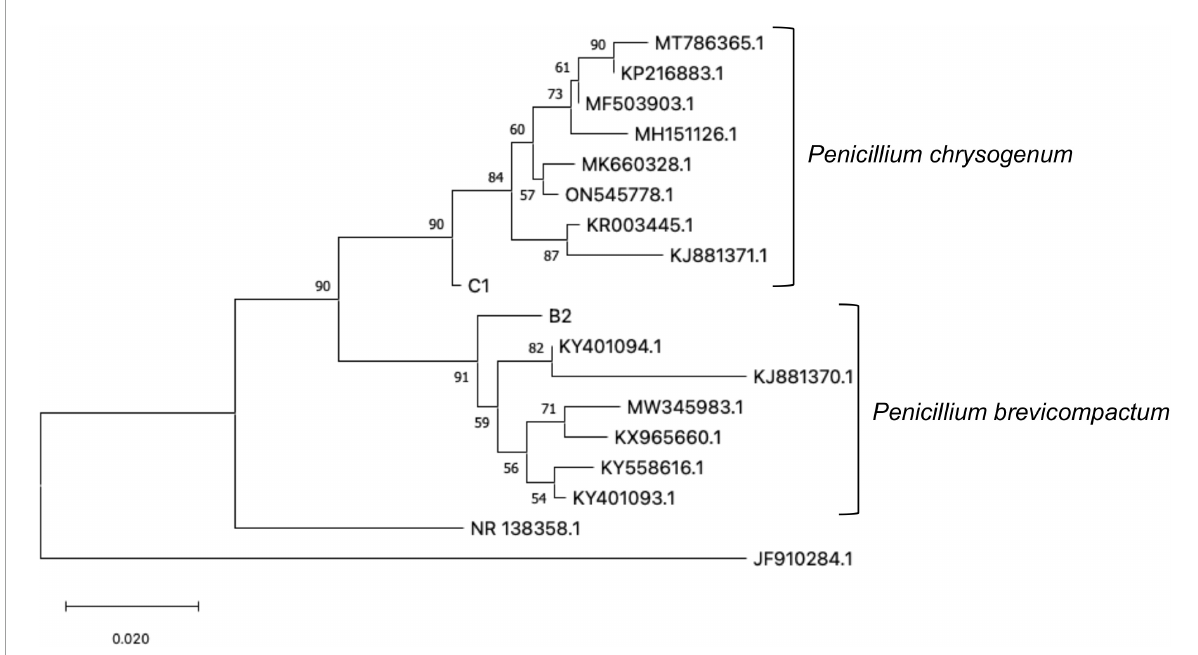
FIGURE1 Phylogenetic relationship tree between 45 sequences of endophytic fungi based on the ITS rDNA sequences NCBI sequences: KR003445.1 Penicillium chrysogenum ; MK660328.1 Penicillium chrysogenum ; ON545778.1 Penicillium chrysogenum ; MH151126.1 Penicillium chrysogenum ; MF503903.1 Penicillium chrysogenum ; MT786365.1 Penicillium chrysogenum ; KP216883.1 Penicillium chrysogenum ; MW345983.1 Penicillium brevicompactum ; KY401094.1 Penicillium brevicompactum ; KY558616.1 Penicillium brevicompactum ; KY401093.1 Penicillium brevicompactum ; KX965660.1 Penicillium brevicompactum ; KJ881370.1 Penicillium brevicompactum ; KJ881371.1 Penicillium chrysogenum ; JF910284.1 Penicillium minioluteum ; NR_138358.1 Penicillium murcianum . Values in the branch nodes correspond to